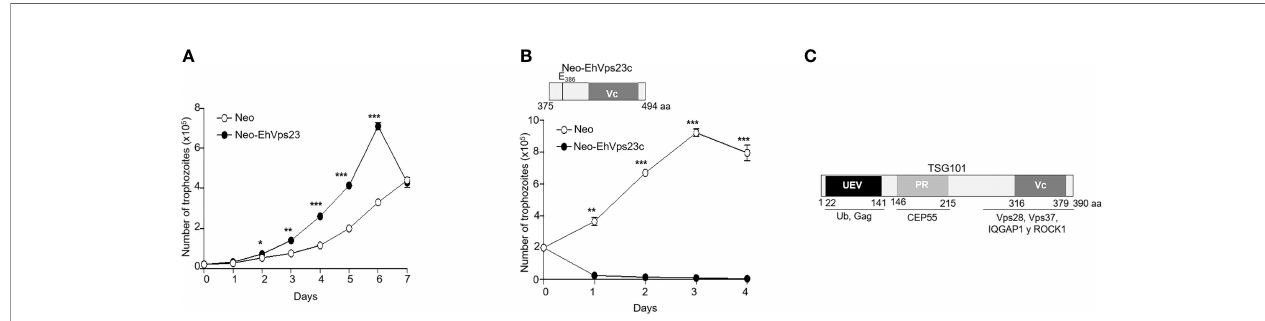
FIGURE 2 | Growth curves of trophozoites transfected with (A) p NeoEhvps23 and (B) pNeoEhvps23 1123-1485 bp plasmids. (C) Scheme of TSG101 protein domains and interaction with other proteins. *P < 0.05, **P < 0.01, ***P <